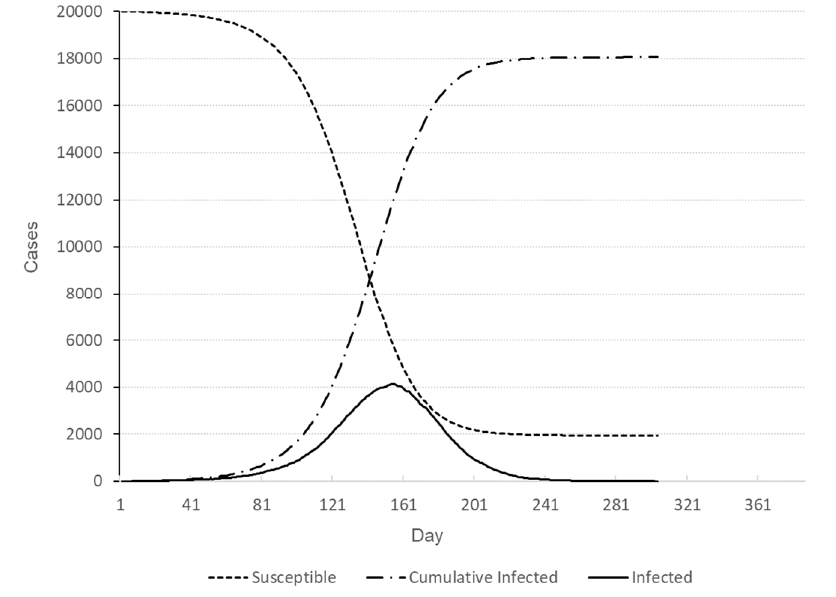
Figure 3. Number of individuals in different states for baseline scenario.